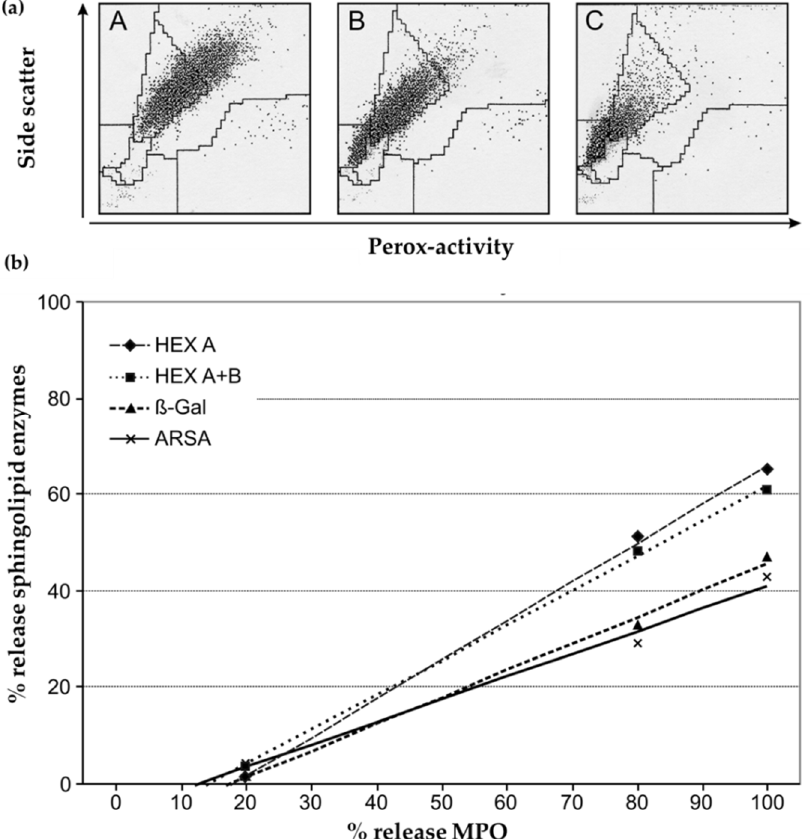
Figure 2. Correlation between release of MPO and other lysosomal enzymes from neutrophilic granulocytes into the supernatant: ( a ) Localization of the neutrophilic population (ADVIA 120, Histopaque separation) after different degranulation conditions: A: incubation without any additives; B: incubation with cytochalasin B + N-fMLP; C: incubation with granulocyte